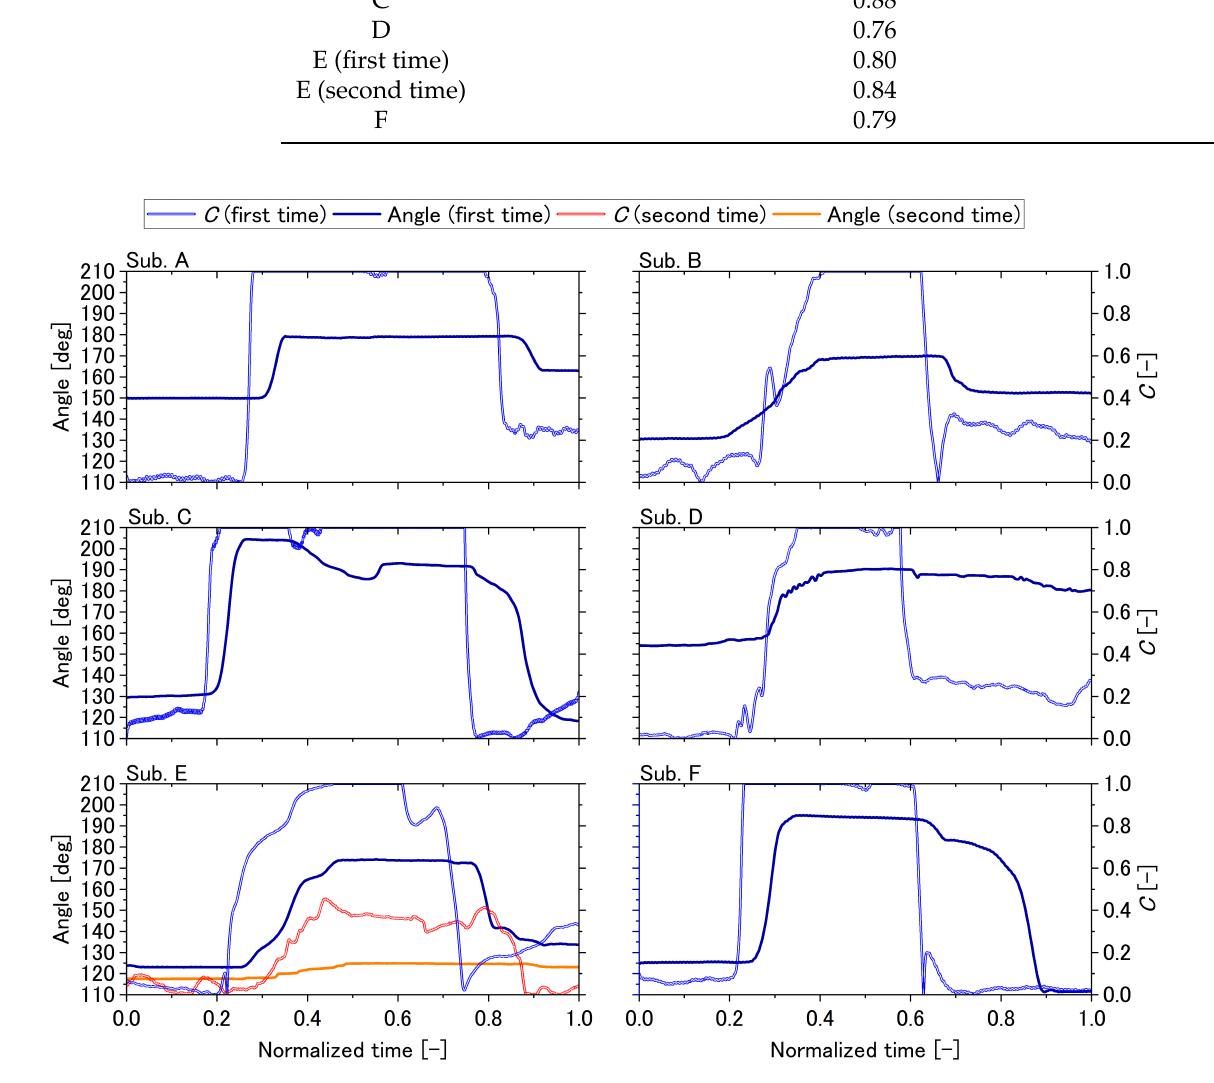
Figure 8. The results of the six subjects for controlling the joint angle using earable Ω as an interface. Subject C clenched and increased C from about 0.1 to 1.0 all at once and maintained it, including a short reduction period, which later reduced to about 0.0 and then gradually increased to 0.2. His MP joint angle followed this trajectory in the range of approximately 130 ◦ to 205 ◦ until a short clenching reduction period. However, after this period, the MP joint angle was reduced to about 190 ◦ even though C was maintained at 1.0. Furthermore, C was reduced from 1.0 to 0.0 all at once, the MP joint angle was decreased gradually with an initial rapid small reduction, and finally reduced to about 120 ◦ , which was smaller than the initial MP joint angle. Subject D clenched and increased C from about 0.0 to 1.0 relatively slowly with initially small vibrations and maintained it, which later reduced to about